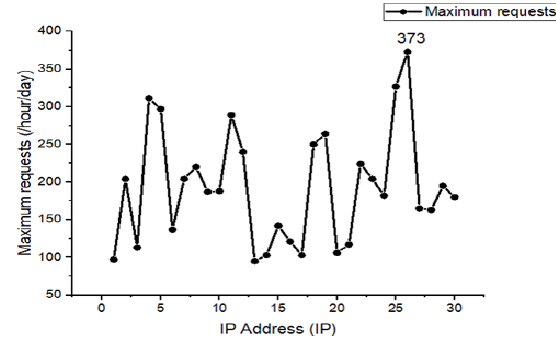
Fig 6: Maximum Request Count from various IP’s The maximum request value arriving from multiple IP addresses irrespective of the requested content are based on the 78 observation in the